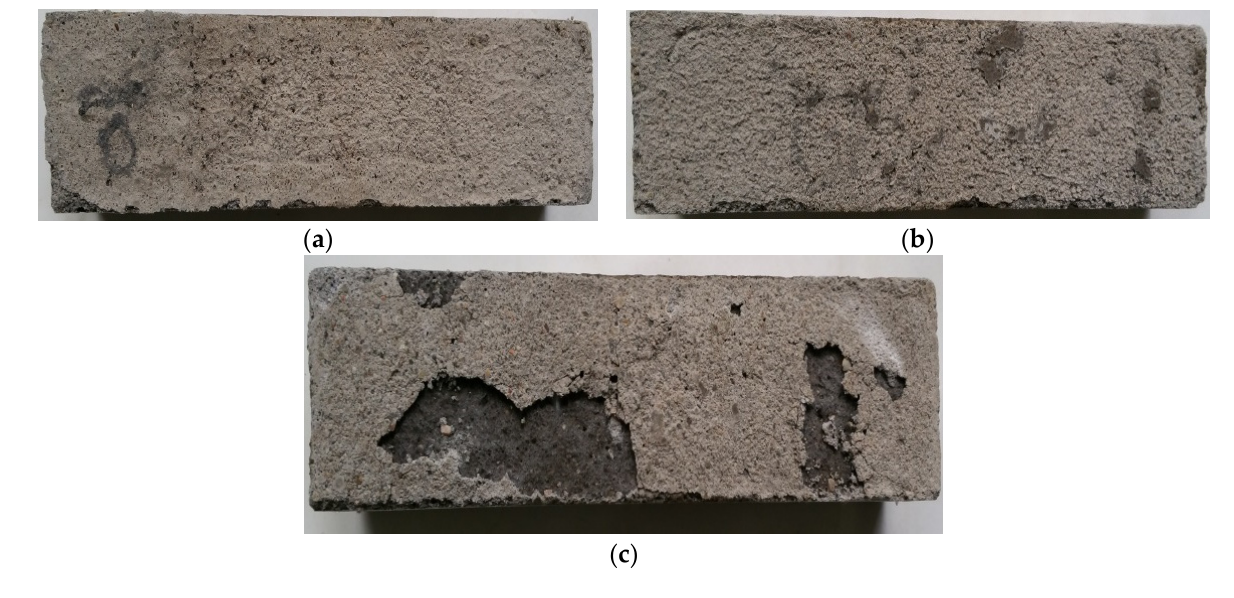
Figure 5. The appearance of the C30 concrete at different attack ages. ( a ) 60 d; ( b ) 180 d; ( c ) 360 d.